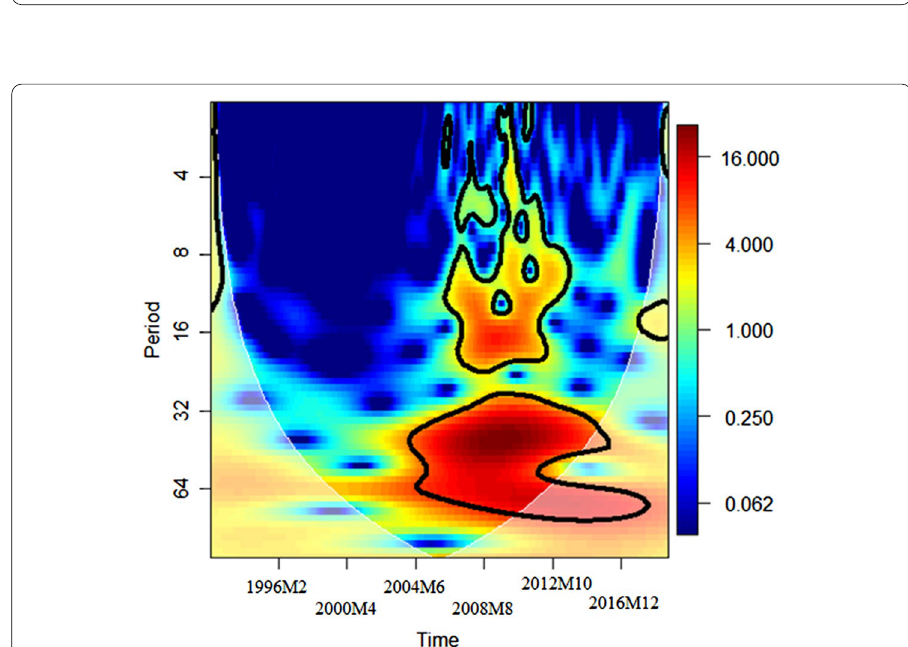
Fig. 4 Wavelet power spectrum for industry input price